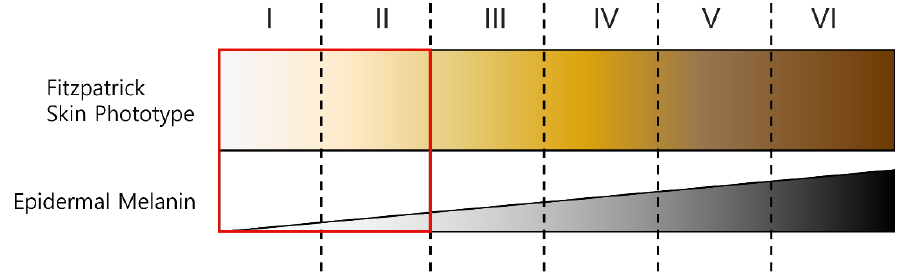
Figure 6. Fitzpatrick skin type and the type used in experiment.